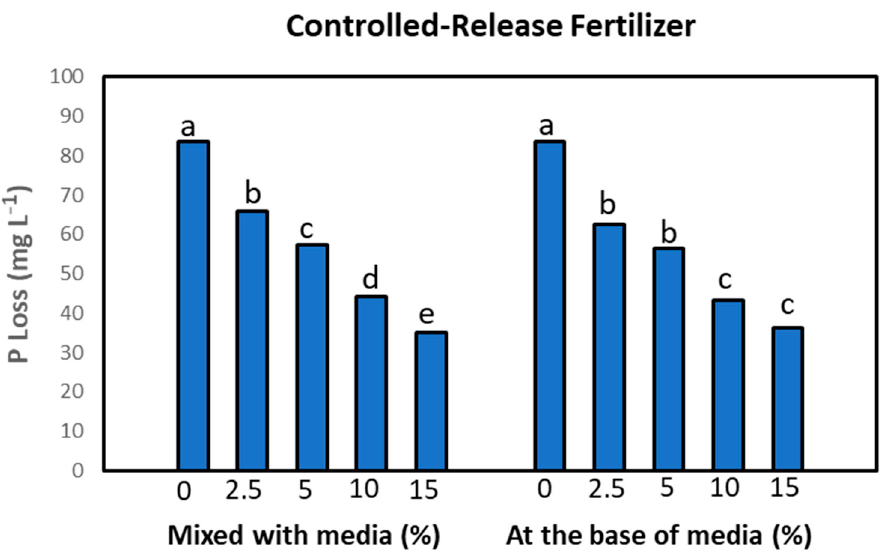
Figure 3. Mean dissolved reactive phosphorus (DRP) concentration loss in leachate as affected by FGD gypsum mixed with media or placed at the bottom of containers fertilized with a controlled- release fertilizer. Within each gypsum application method, bars with the same letter are not signifi- cantly different ( p < 0.05).